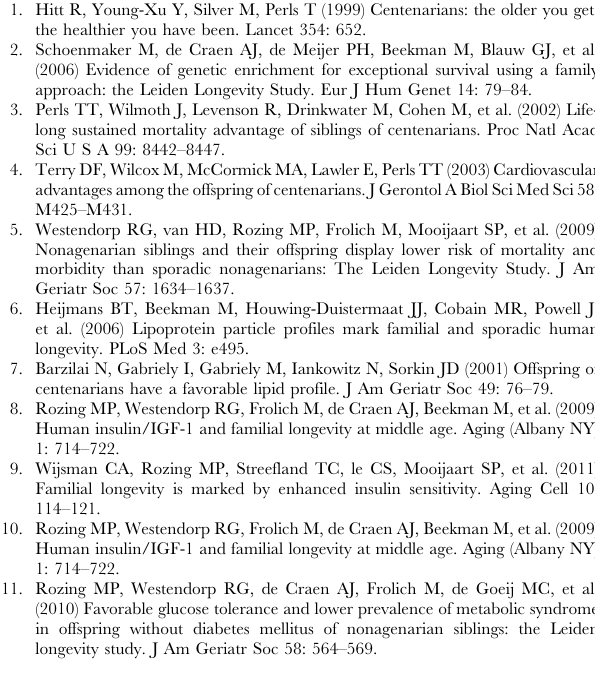
Figure S1 Distribution of expression intensities of 2,953 age-related probes. The x-axis indicates average log2 expres- sion intensities of all samples; the y-axis indicates the log2 fold change between nonagenarians and controls. Black circles represent all 45,164 probes; red filled dots represent the 2,953 age-related probes with a FDR # 0.05. Table S1 Significant gene expression changes with chronological age and/or familial longevity. A total of 2,953 probes whose expression level changed significantly between controls and long-lived nonagenarians (regression modeling with FDR multiple testing correction) are shown. The table also indicates the chromosomal location of the probe. ‘‘FC’’ indicates the fold change between groups, a FC above 1 indicates increased expression in nonagenarians compared to controls, and a FC below 1 indicates decreased expression in nonagenarians com- pared to controls. MULTIPLE indicates a probe annotated to more than three chromosomal locations. Table S2 GO terms found significantly differentially expressed between nonagenarians and controls. Globalt-